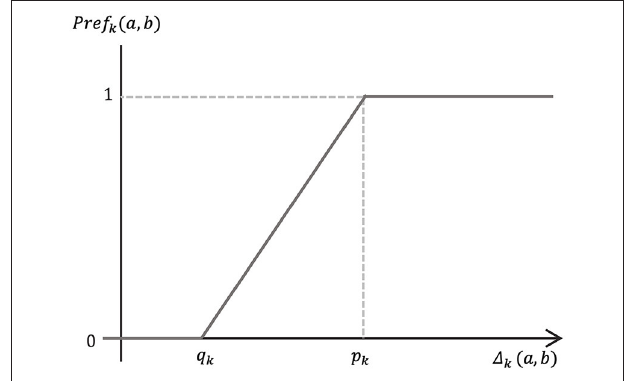
FIGURE 5 | V-shape preference function. Adapted from Brans and Vincke